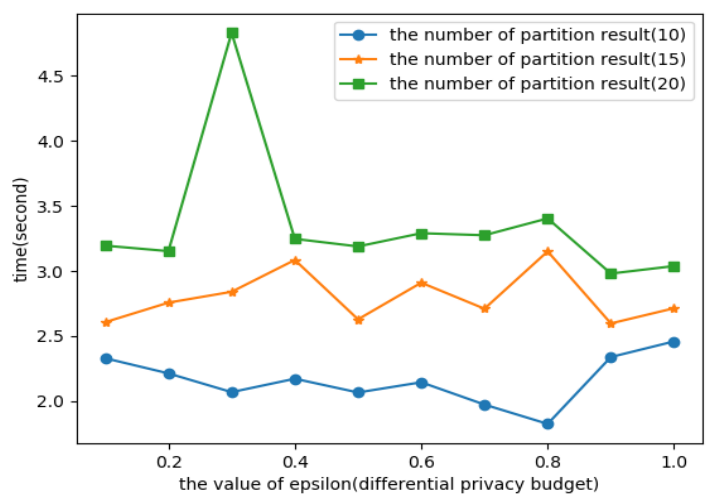
Figure 15. The time cost with different epsilon (T-drive